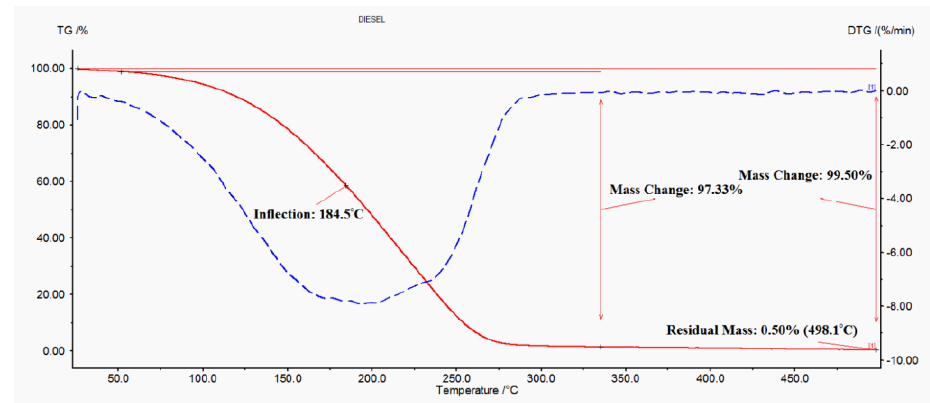
Figure 2. DSC combustion curve for B20 JOME.